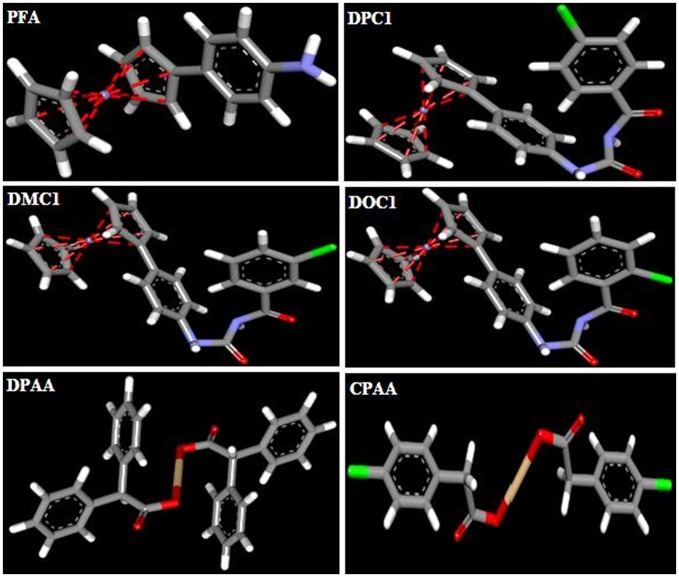
3D-structures of ferrocene incorporated acyl ureas and homoleptic cadmium carboxylates: 4-ferrocenyl aniline (PFA), 1-(4-chlorobenzoyl)-3-(4-ferrocenylphenyl) urea (DPC1), 1-(3-chlorobenzoyl)-3-(4-ferrocenylphenyl) urea (DMC1), 1-(2-chlorobenzoyl)-3-(4-ferrocenylphenyl) urea (DOC1), bis (diphenylacetato) cadmium (II) (DPAA), and bis (4-chlorophenylacetato) cadmium (II) (CPAA), drawn through Guass View 5.0 Software and saved into PDB format. Atoms are shown by colors; gray color (carbon atoms), white color (hydrogen atoms), red color (oxygen atoms), blue color (nitrogen atoms), yellowish color (cadmium atoms), and green color (chlorine atoms).